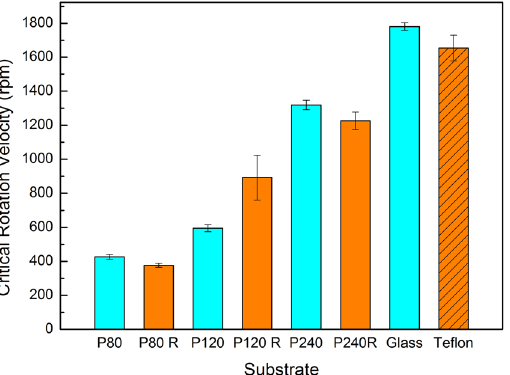
Figure 2. Critical rotational velocities versus substrates with varying surface roughness and wettability. Results show that the suckers perform better adhesion ability with decreasing surface roughness. The blue bars are the PDMS replicas of original mold sand paper (red bars on the left). The sand paper is more hydrophilic than its replicas. The glass slide is hydrophilic whereas the Teflon is hydrophobic, both of which are smooth (with roughness < 5 μ